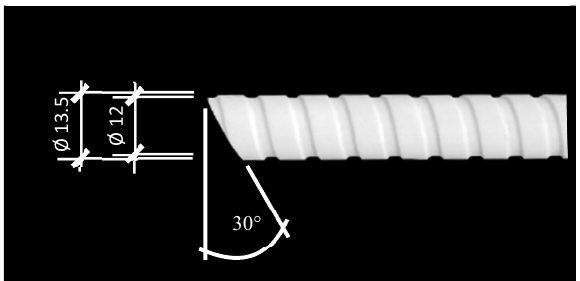
Figure 2. The geometry of the examined connector’s head made out of glass fibre reinforced